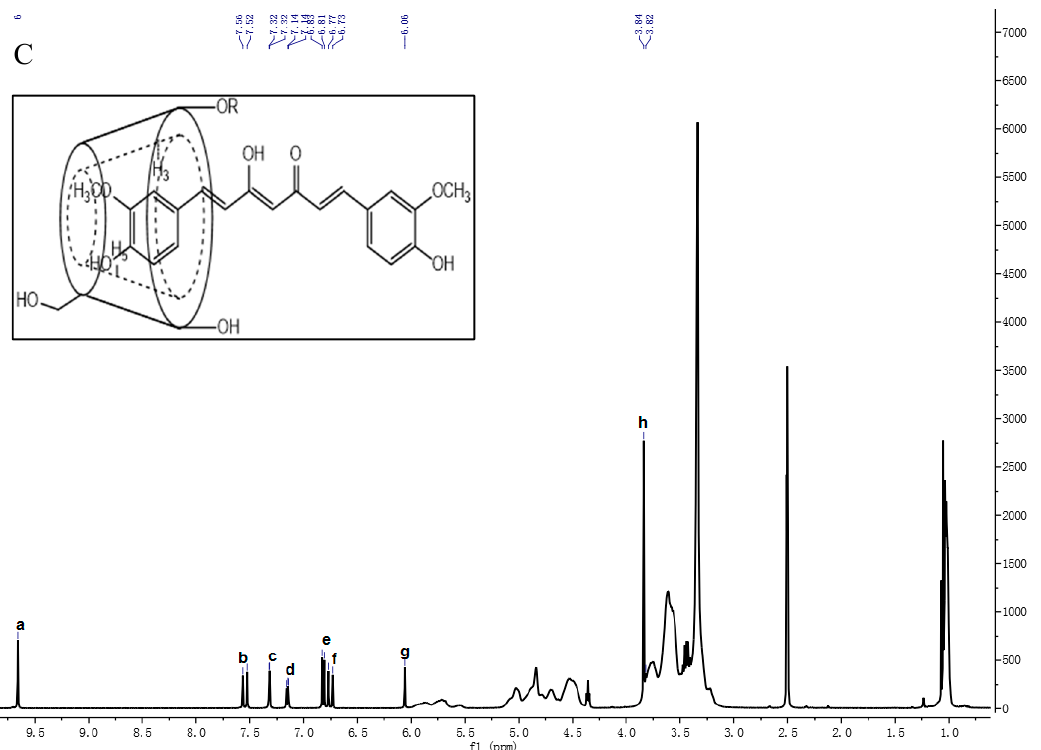
Figure 8. The 1H-NMR spectrum and intermolecular interaction of ( A ) PV4; ( B ) PO4; and ( C ) HP4.